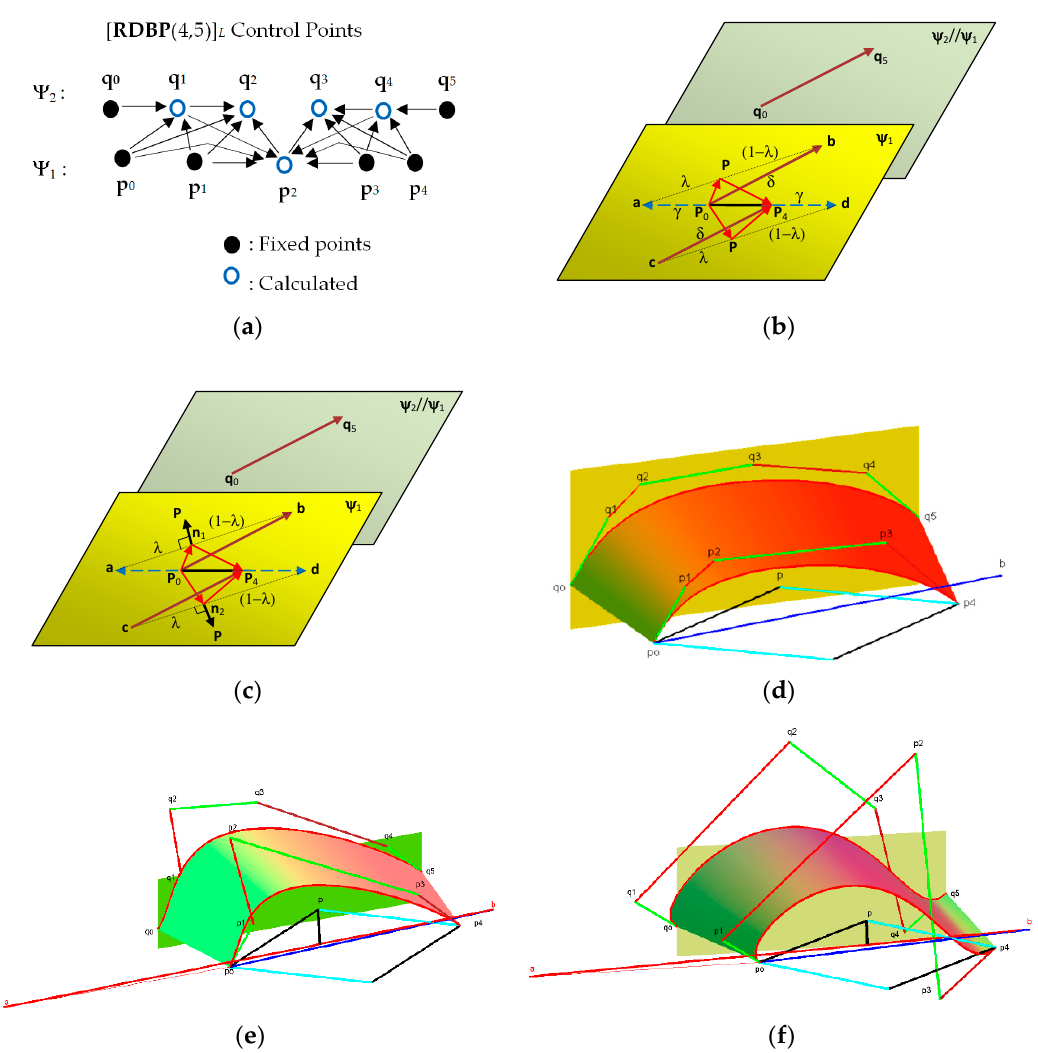
Figure 2. Setting the Bézier control points and the centroid point [RDBP(4 , 5)] L .